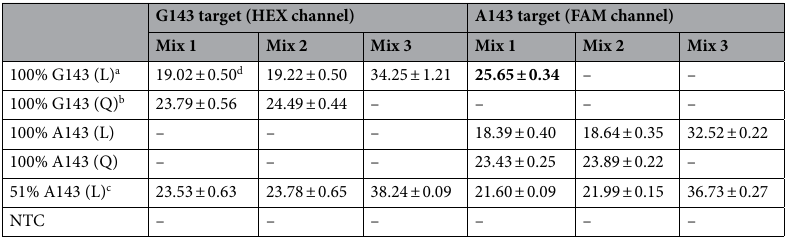
Table 5. Cq values obtained from the assessment of three qPCR mastermixes. Mix 1 (iQ Multiplex Supermix), Mix 2 (Sensifast Probe No-Rox mix) and Mix 3 (Immomix), with total DNA of leaves infected with wild type (G143) and mutant (A143) wheat powdery mildew. Non-target amplification is indicated in bold. a DNA extracted using a standard laboratory method. b DNA extracted using the quick field extraction method. c 49% G143. d s.d. (5